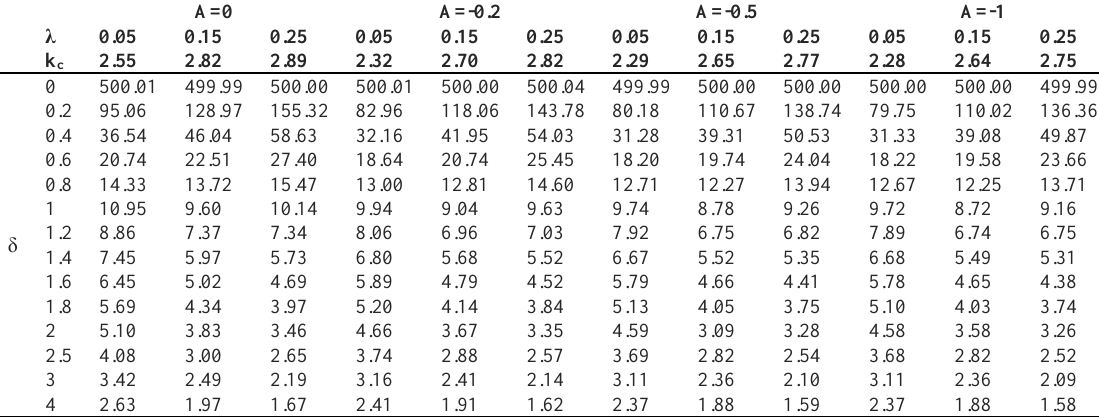
Table 1. ARL zero-state constant limit one-sided EWMA.